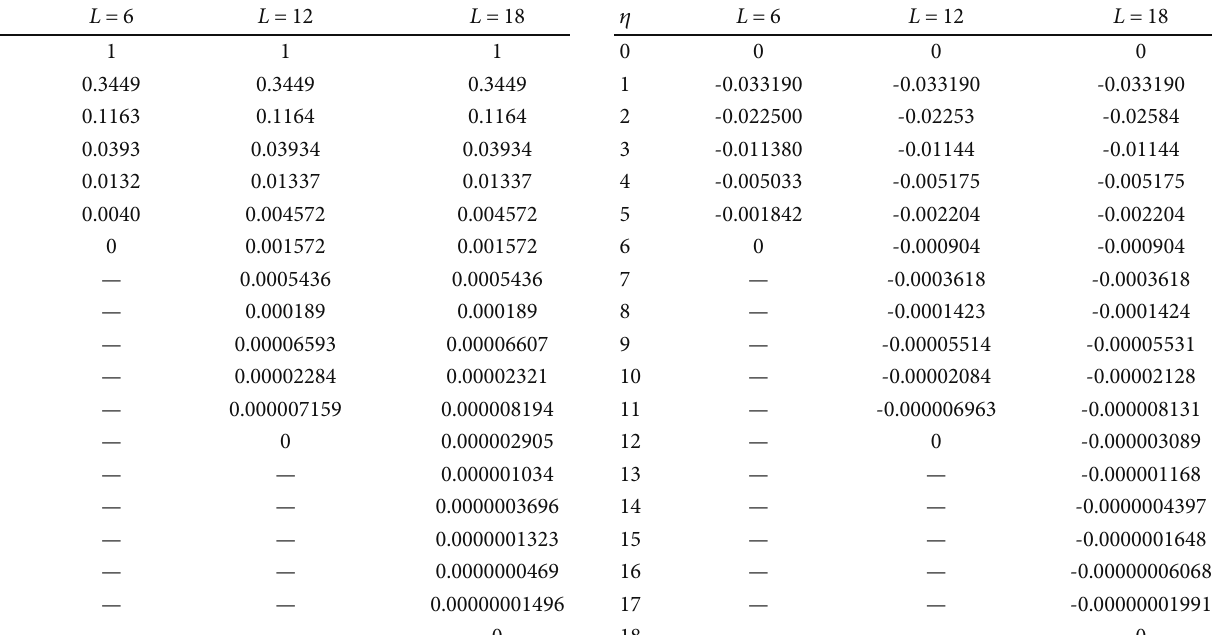
Table 1: Real part of velocity pro fi le at L = 6,12,18 . Table 2: Imaginary part of velocity pro fi le at L = 6,12,18 .